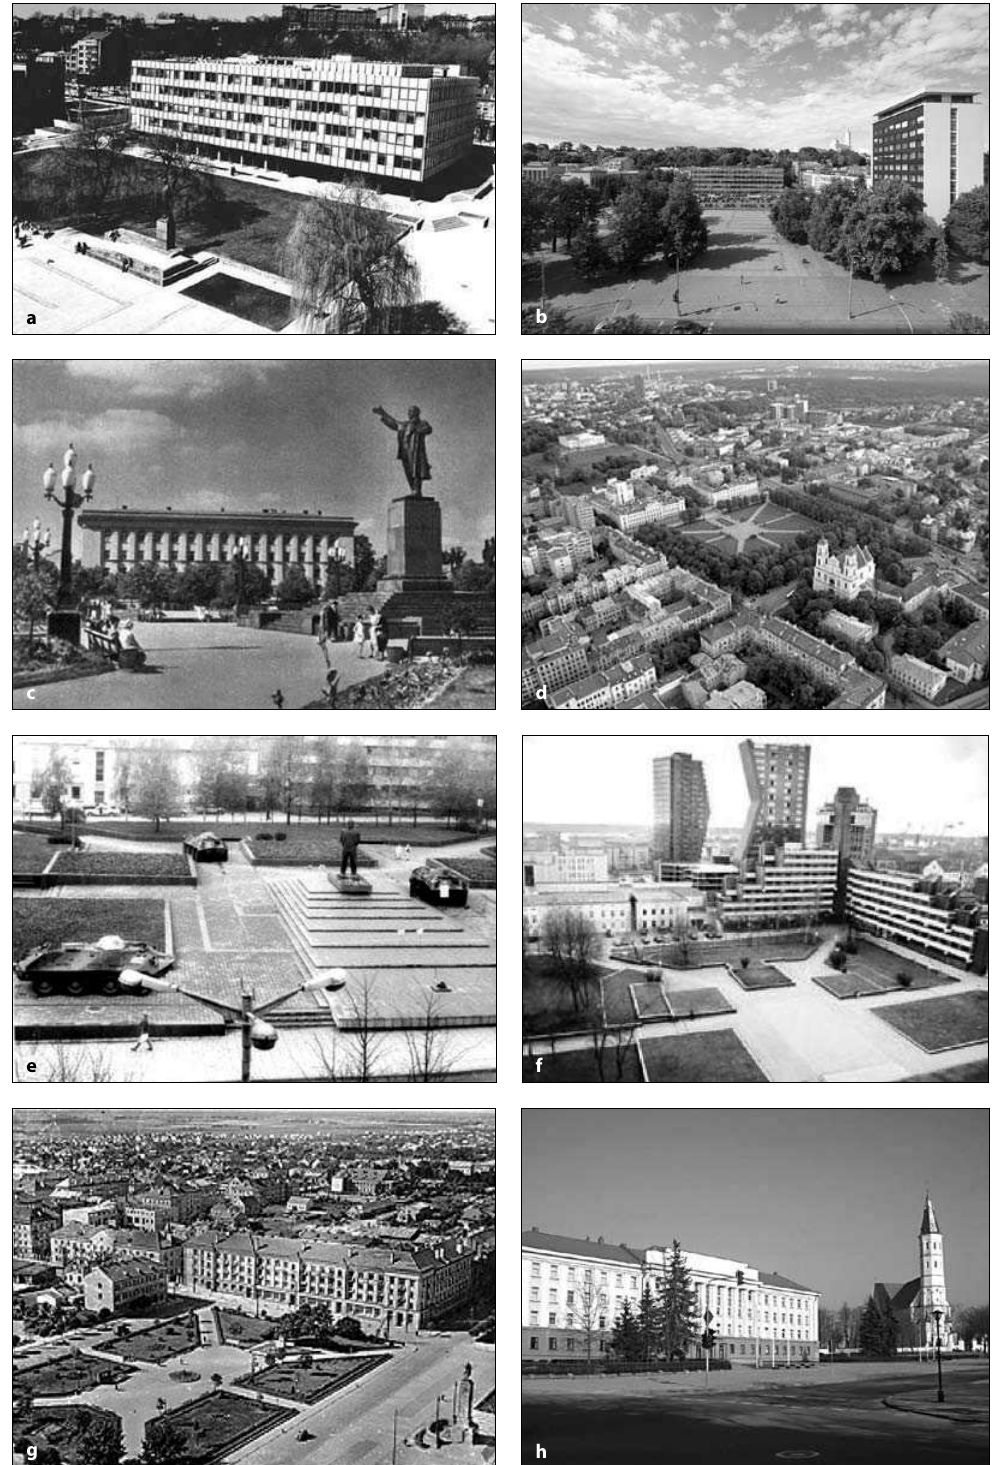
Fig. 2. examples of transformations of the main representative public spaces: a, b – Union (former Janonis’) Square in kaunas; c, d – Lukiškių (former Lenin’s) Square in Vilnius; e, f – revival (former Lenin’s) Square in klaipėda; g, h – resurrection (former Victory) Square in